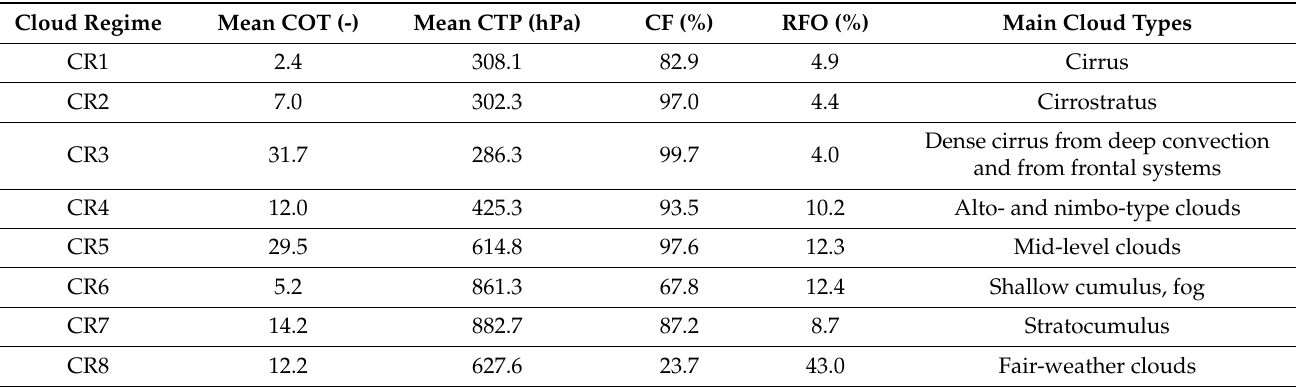
Table 1. Summary of the 8 CRAAS cloud regimes (CRs) including the mean properties and the main cloud types associated to each of the cloud